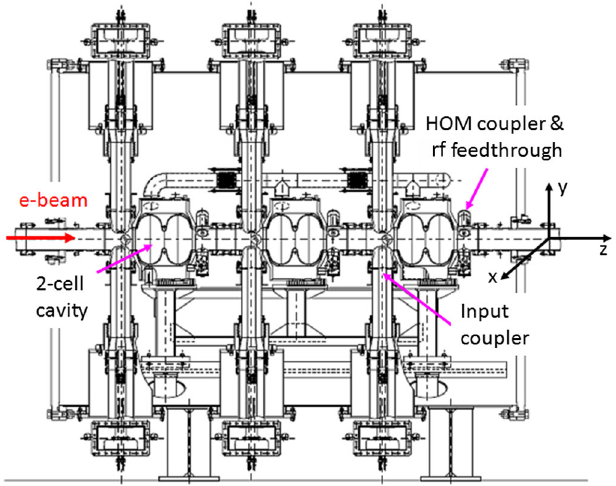
FIG. 11. Schematic of cERL injector cryomodule. The cry- omodule includes three 1.3 GHz 2-cell superconducting cavities. Each cavity has two input couplers and five loop-type HOM